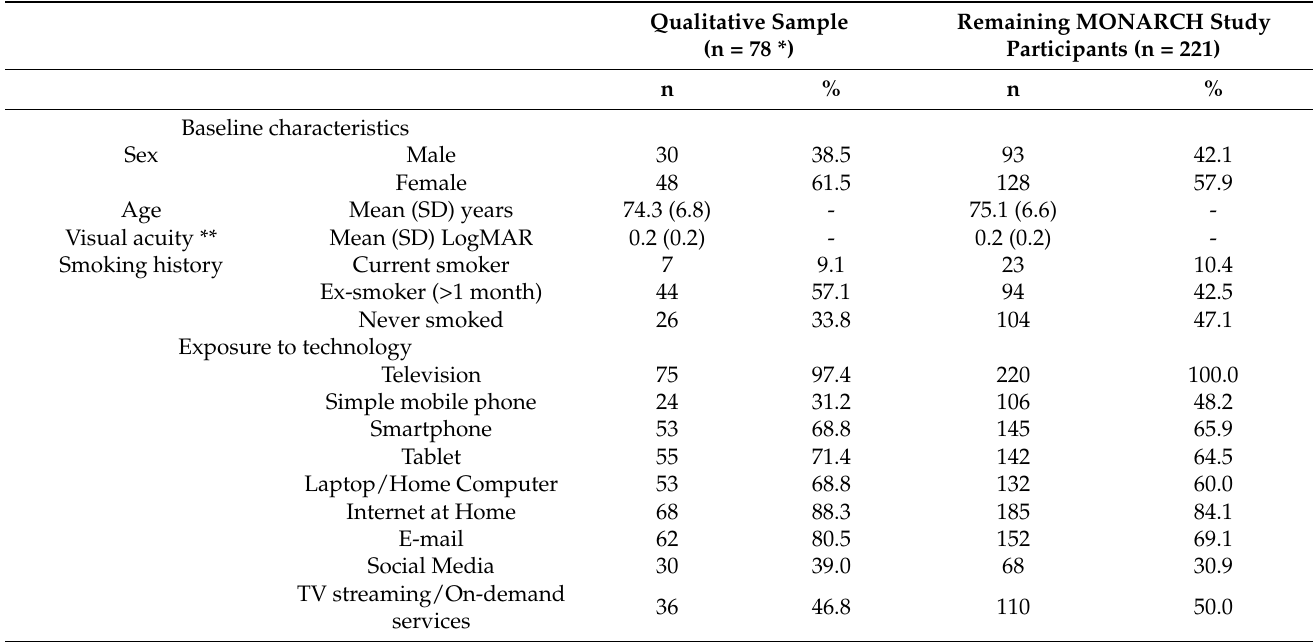
Table 2. Sociodemographic characteristics of participants in the qualitative component of the MONARCH study compared to the rest of the MONARCH study sample.